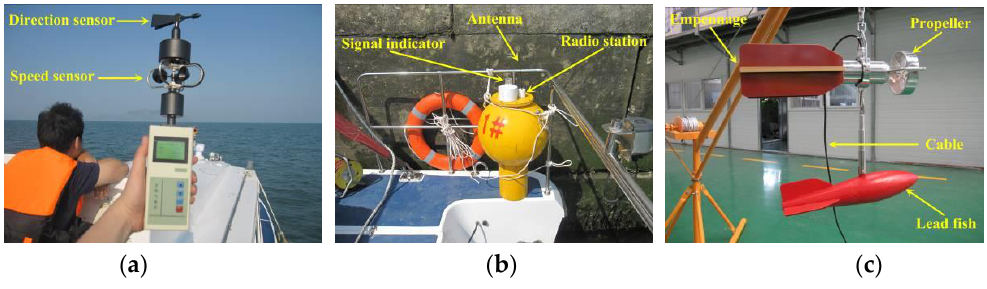
Figure 15. Equipment for environment measurement: ( a ) anemometer; ( b ) wave buoy; and ( c ) tachometer.